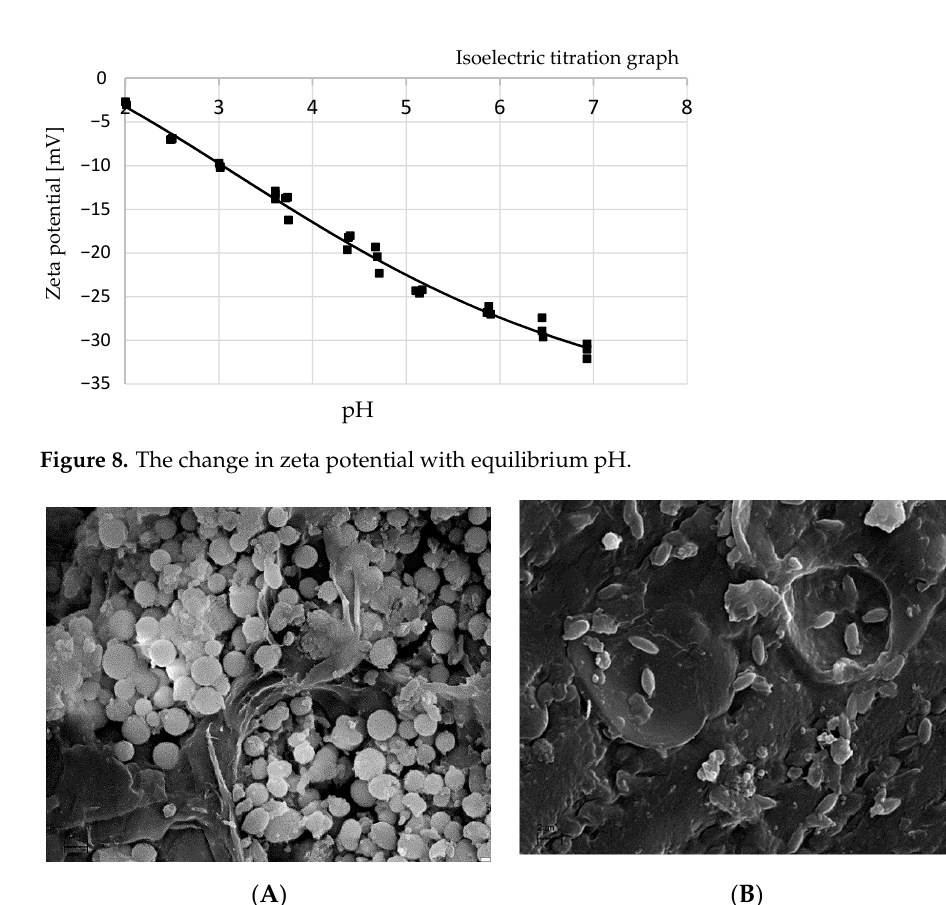
Figure 9. SEM images of BG residues: ( A ) magn.: ×10,000, scale bar: 2 μ m, ( B ) ×10,000, 2 μ m.